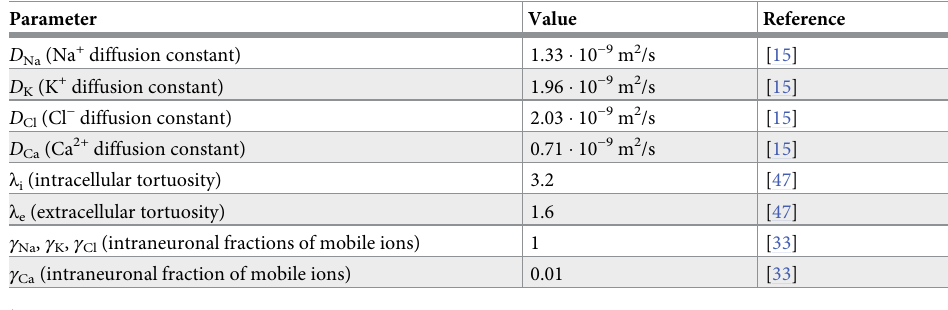
Table 2. Diffusion constants, tortuosities, and intraneuronal fractions of mobile ions † .